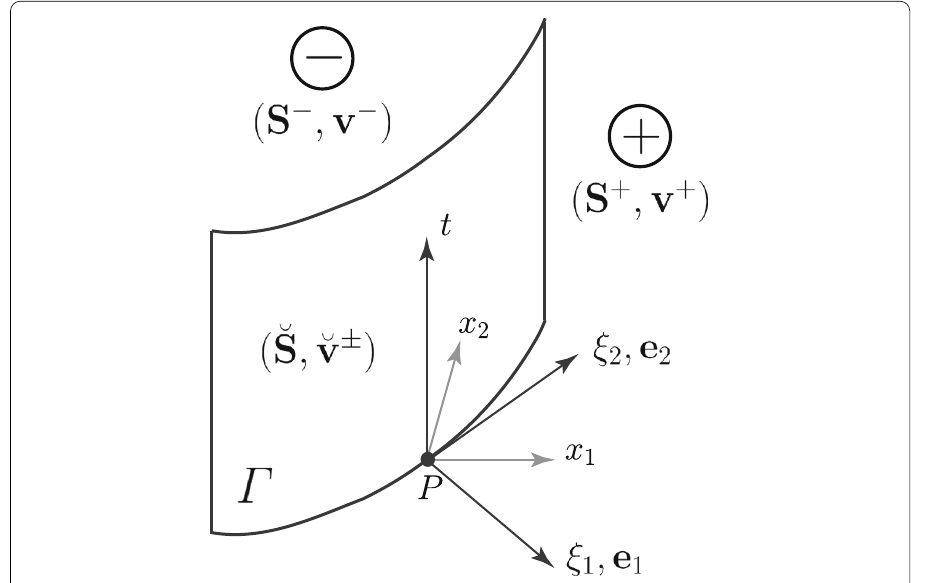
Fig. 2 Local coordinate frame at location P on a spacetime fracture interface (cid:4) for a problem in two spatial dimensions ( d = 2). Traces of the stress and velocity fields from opposing sides, ( S ± , v ± ), determine the Riemann values, ( ˘ S , ˘ v ± ), on